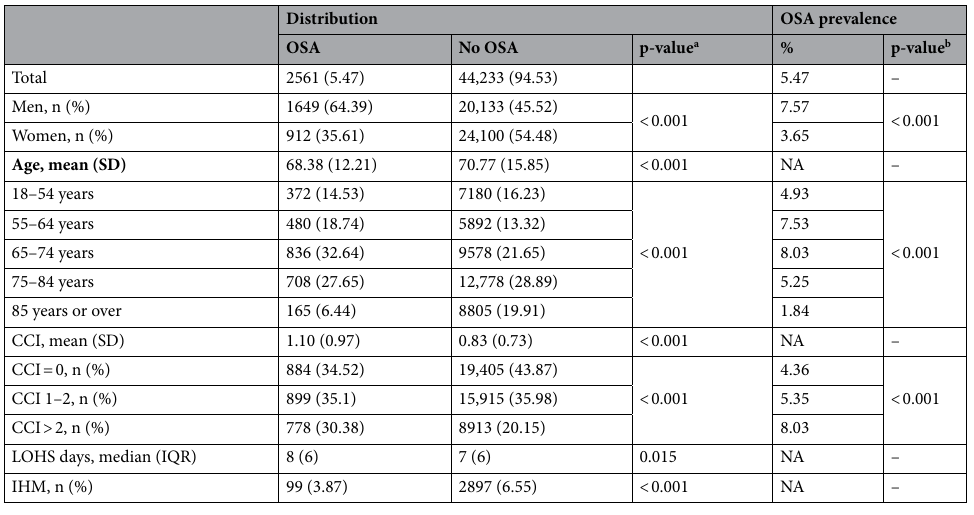
Table 1. Distribution and prevalence by sex, age, clinical characteristics, and hospital outcomes of patients hospitalized with pulmonary embolism (PE) according to the presence of obstructive sleep apnea. OSA Obstructive sleep apnea, CCI Charlson comorbidity index, LOHS Length of hospital stay, IHM In-hospital mortality, SD Standard deviation, IQR Interquartile range, NA Not applicable. a P value for comparison of OSA with non-OSA patients. b P value for association of the prevalence of OSA according to sex, age groups,